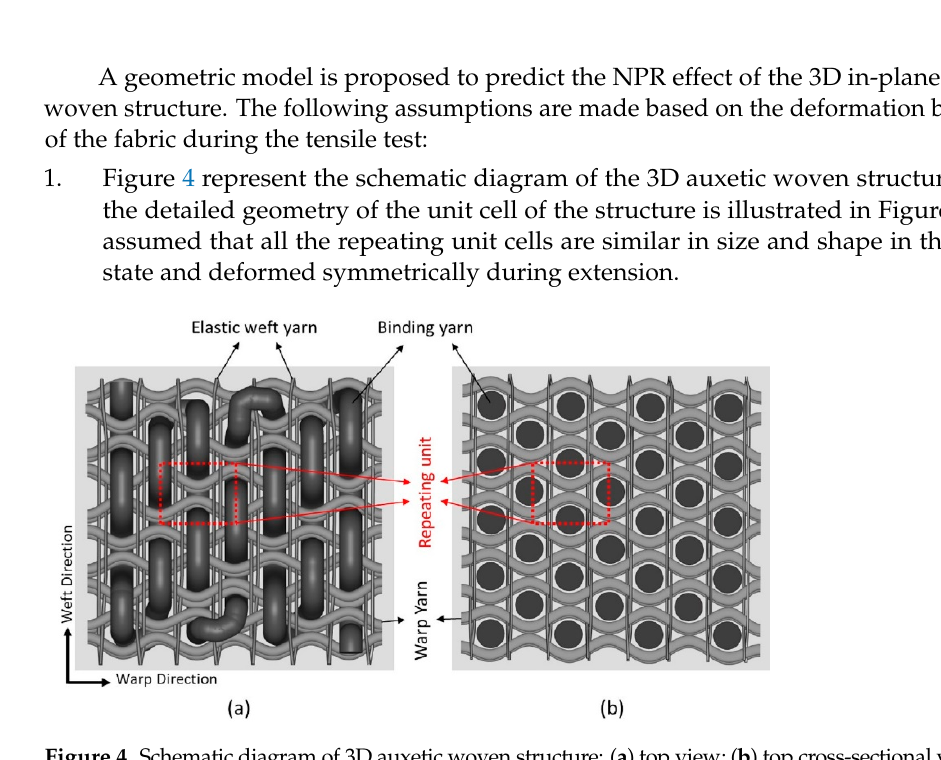
Figure 4. Schematic diagram of 3D auxetic woven structure: ( a ) top view; ( b ) top cross-sectional view [31].